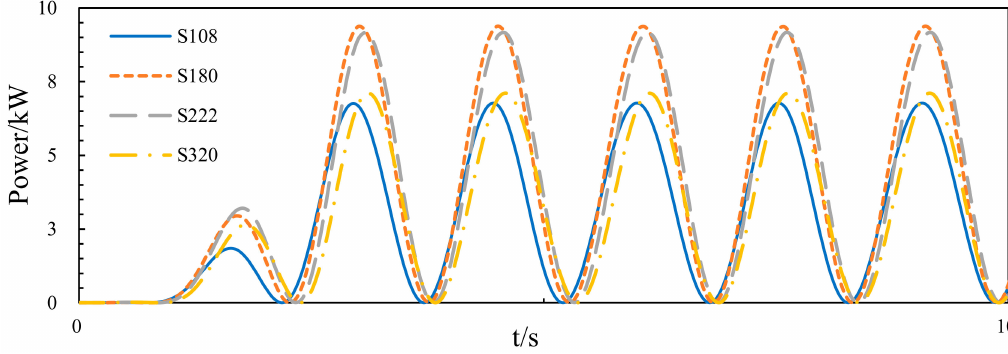
Figure 11. The instantaneous power curves of Buoy